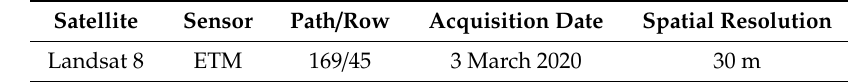
Table 1. Details of acquired satellite image.